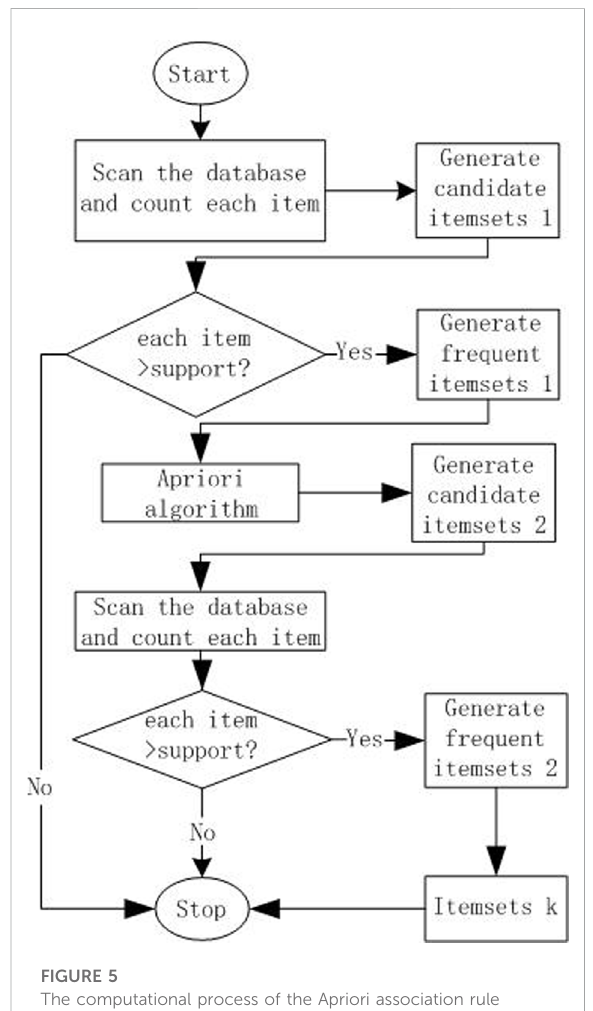
FIGURE 5 The computational process of the Apriori association rule algorithm.